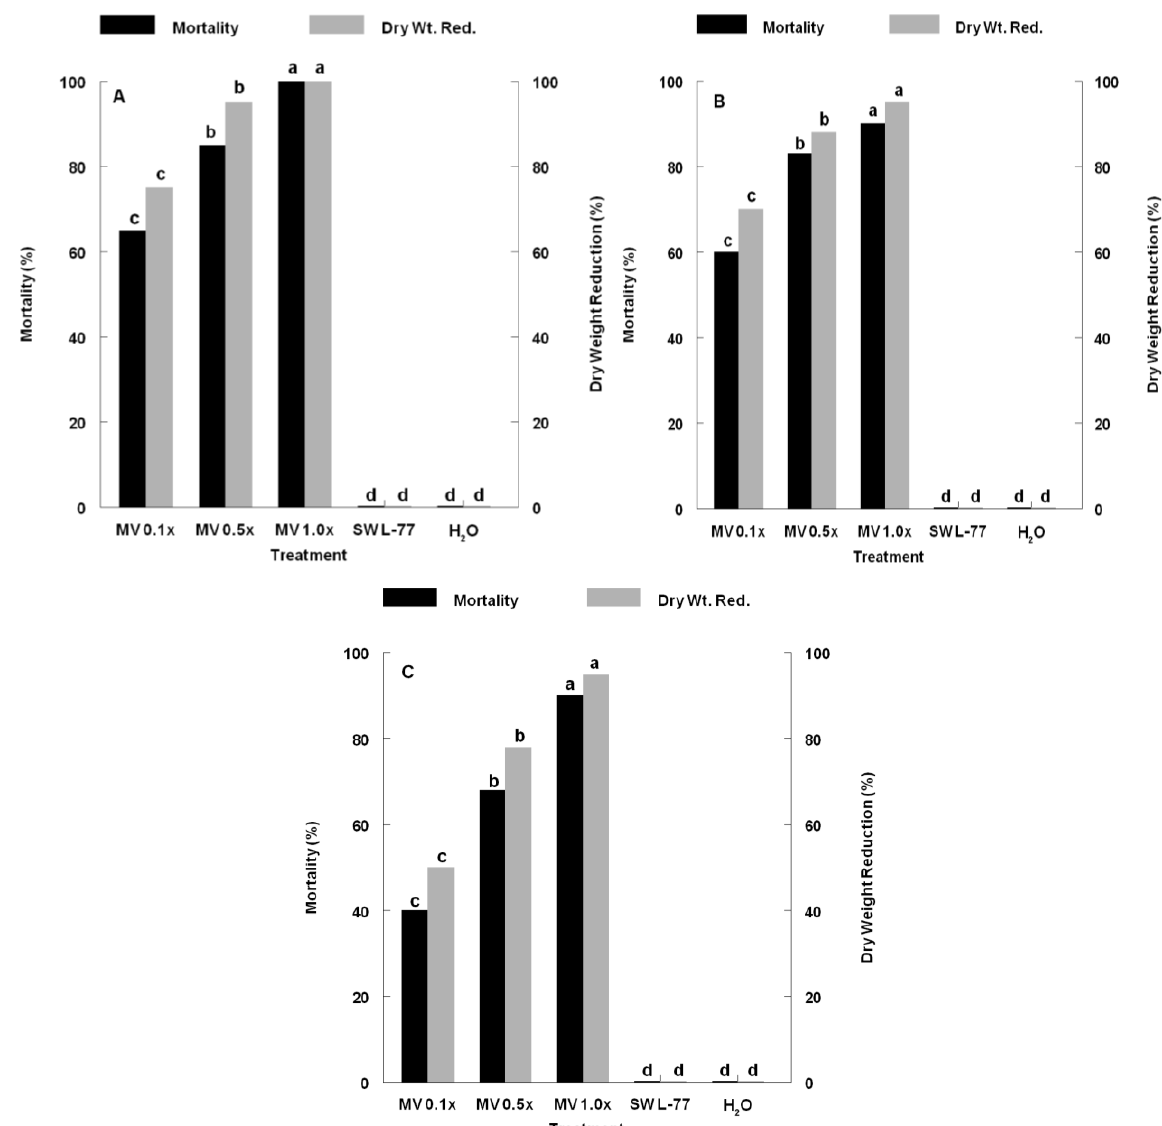
Figure 1. Effect of Myrothecium verrucaria mycelial concentration on mortality and dry weight reduction of hemp sesbania in greenhouse experiments, seven days after